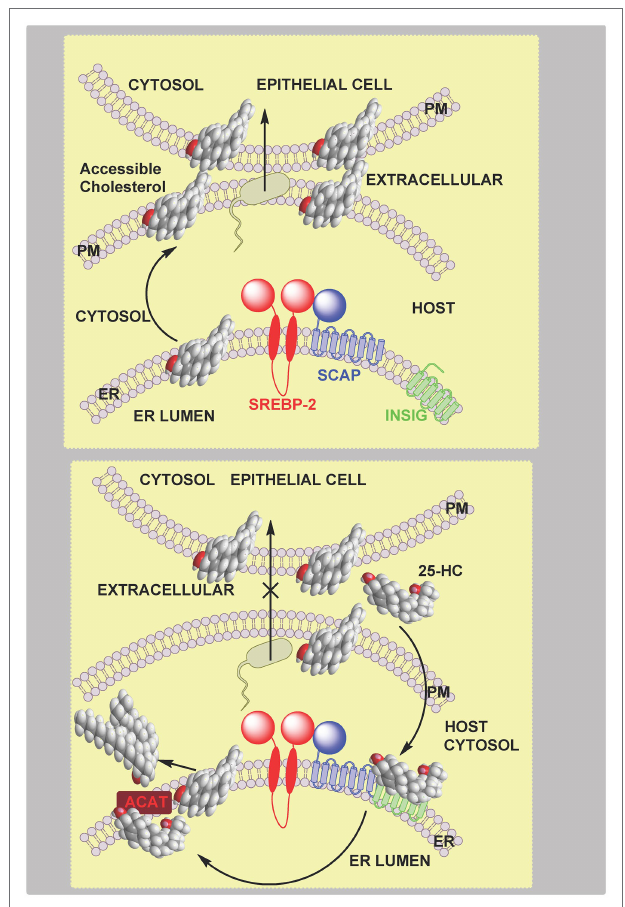
FIGURE 11 | Cartoon representation of the inhibition by 25-HC of bacterial spread between epithelial cells. Upper panel , plasma membrane accessible cholesterol is required for bacterial cell–cell transmission. Lower panel , activated macrophages secrete 25-HC which stimulates the endoplasmic reticulum-located enzyme ACAT/SOAT to rapidly esterify cholesterol for storage in lipid droplets leading to reduced accessible cholesterol in the plasma membrane, this prevents bacterial spread across neighboring cells. A supporting role in reducing accessible cholesterol is played by inhibition of the SREPB-2 pathway but over a longer